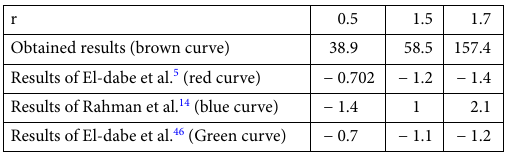
Table 1. Velocity field for special